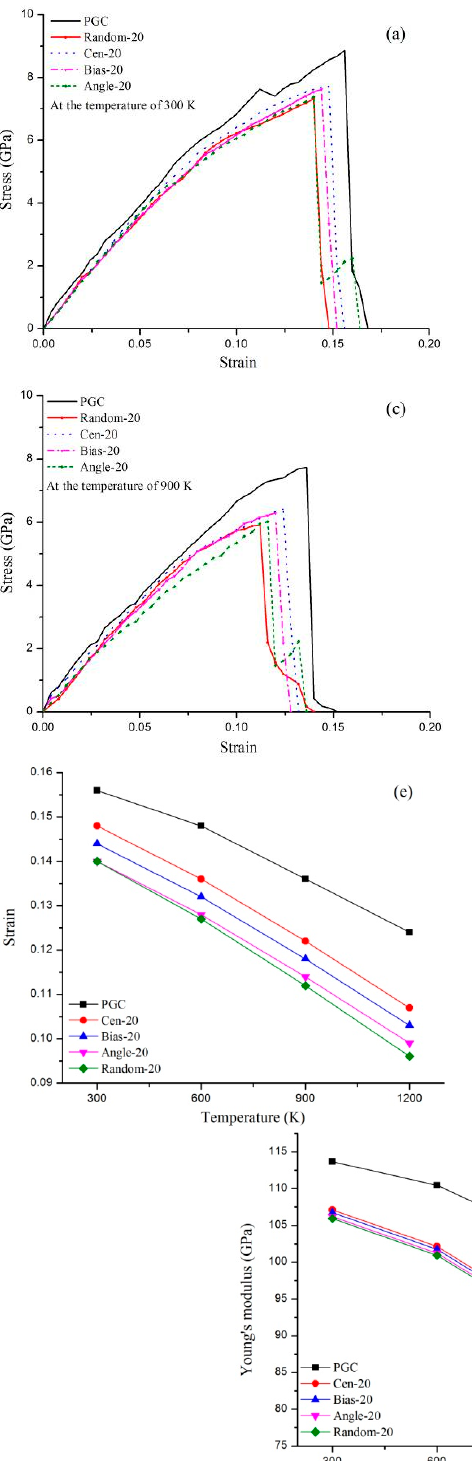
defects are created in graphene by using 20 directional ions irradiation.